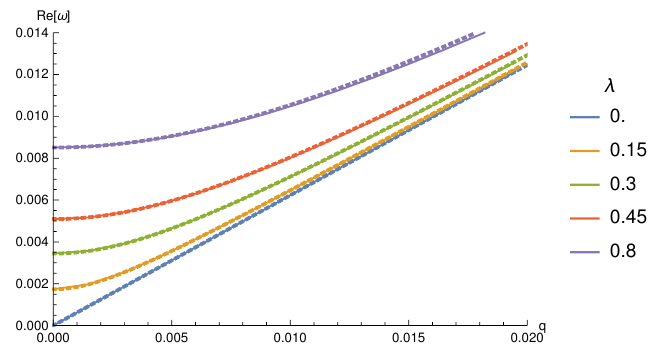
Figure 5 . Dispersion relation of the pinned phonon at di(cid:11)erent explicit lattice amplitudes. Solid lines show the numerical data for momentum dependent QNMs, dashed lines show the disper- sion (1.1) with parameters obtained from QNMs at zero momentum, (cid:12)gure 4 and c 0 extracted from (cid:21) = 0 dispersion, (cid:12)gure 2.